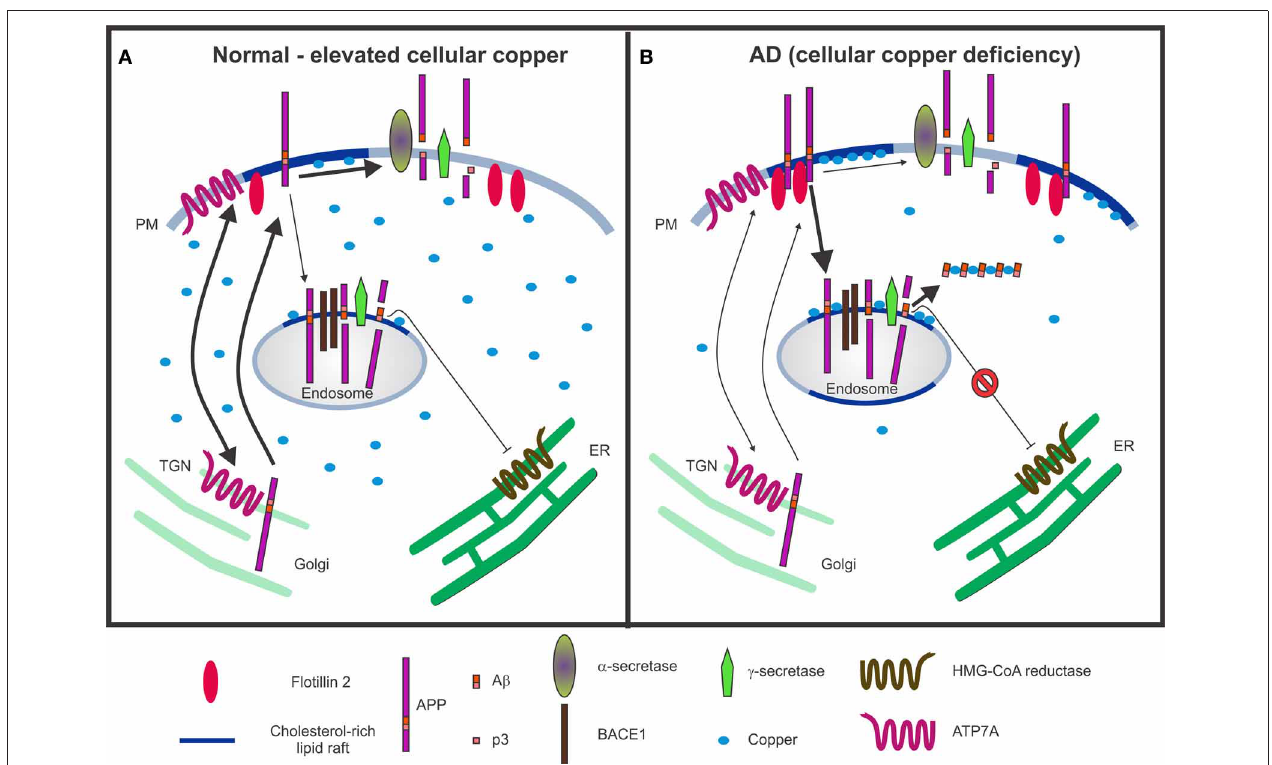
FIGURE 2 | Schematic models illustrating the interactions between copper, cholesterol and APP metabolism. (A) Under normal and/or elevated cellular copper conditions, there is an increased translocation of APP and ATP7A from the trans- Golgi network (TGN) to the plasma membrane (PM), where they participate in copper efflux. The majority of the APP molecules undergo non-amyloidogenic processing via α -secretase cleavage at the cell surface in non-lipid raft membrane domains, which produces a non-toxic p3 fragment. It is expected that a basal level of β -cleavage of APP occurs in cholesterol-rich lipid raft domains of acidic endosomes enriched in BACE1, the β -secretase. A β 40 , the product of the sequential cleavage of APP by β - and γ -secretases, is proposed to inhibit 3-hydroxy-3-methylglutaryl-coenzyme A (HMG-CoA) reductase activity as a part of a feedback mechanism by which